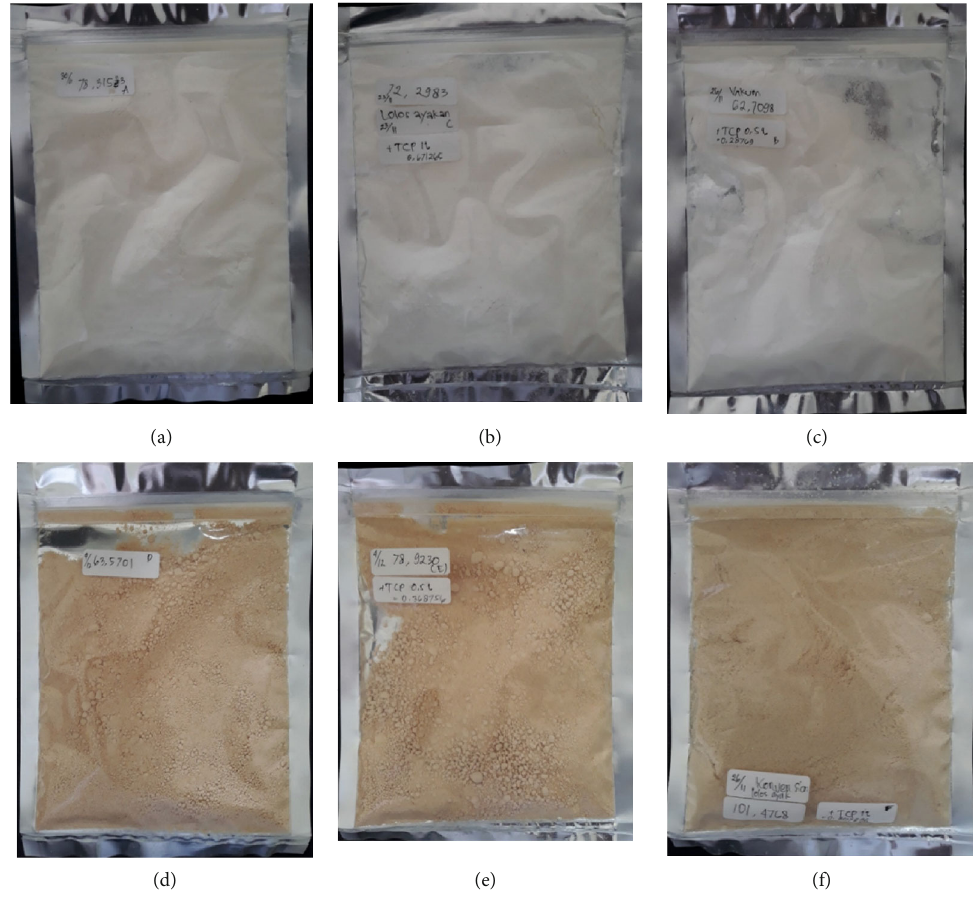
Figure 9: Coconut sugar powder. (a – c) Vacuum-dried sugar without the addition of TCP, with TCP 0.5%, and with TCP 1%, respectively. (d – f) Conventional sugar without the addition of TCP and with the addition of TCP 0.5% and TCP 1%,